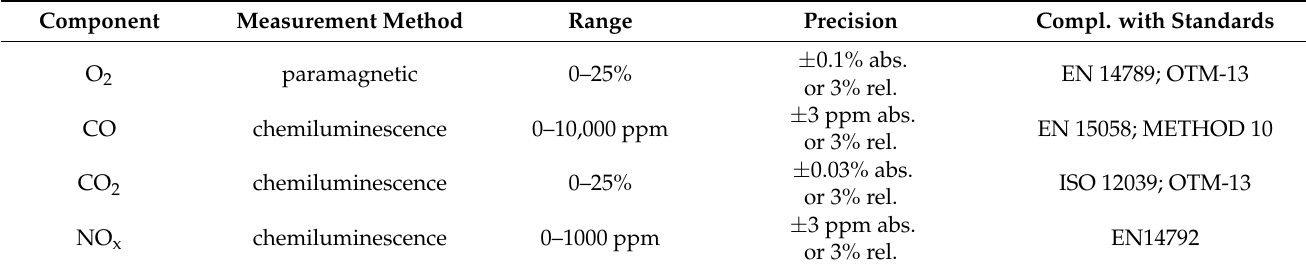
Table 1. Technical specification of the Testo 350 flue gas analyzer.